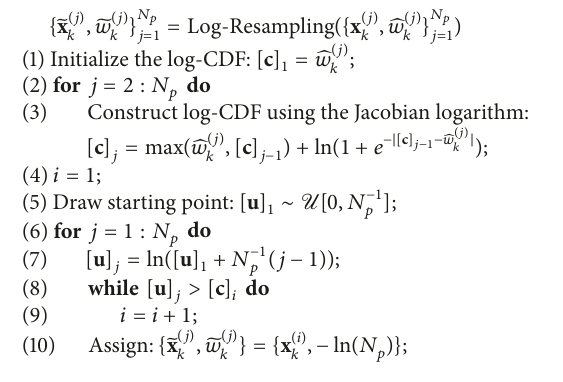
Algorithm 4: Resampling in